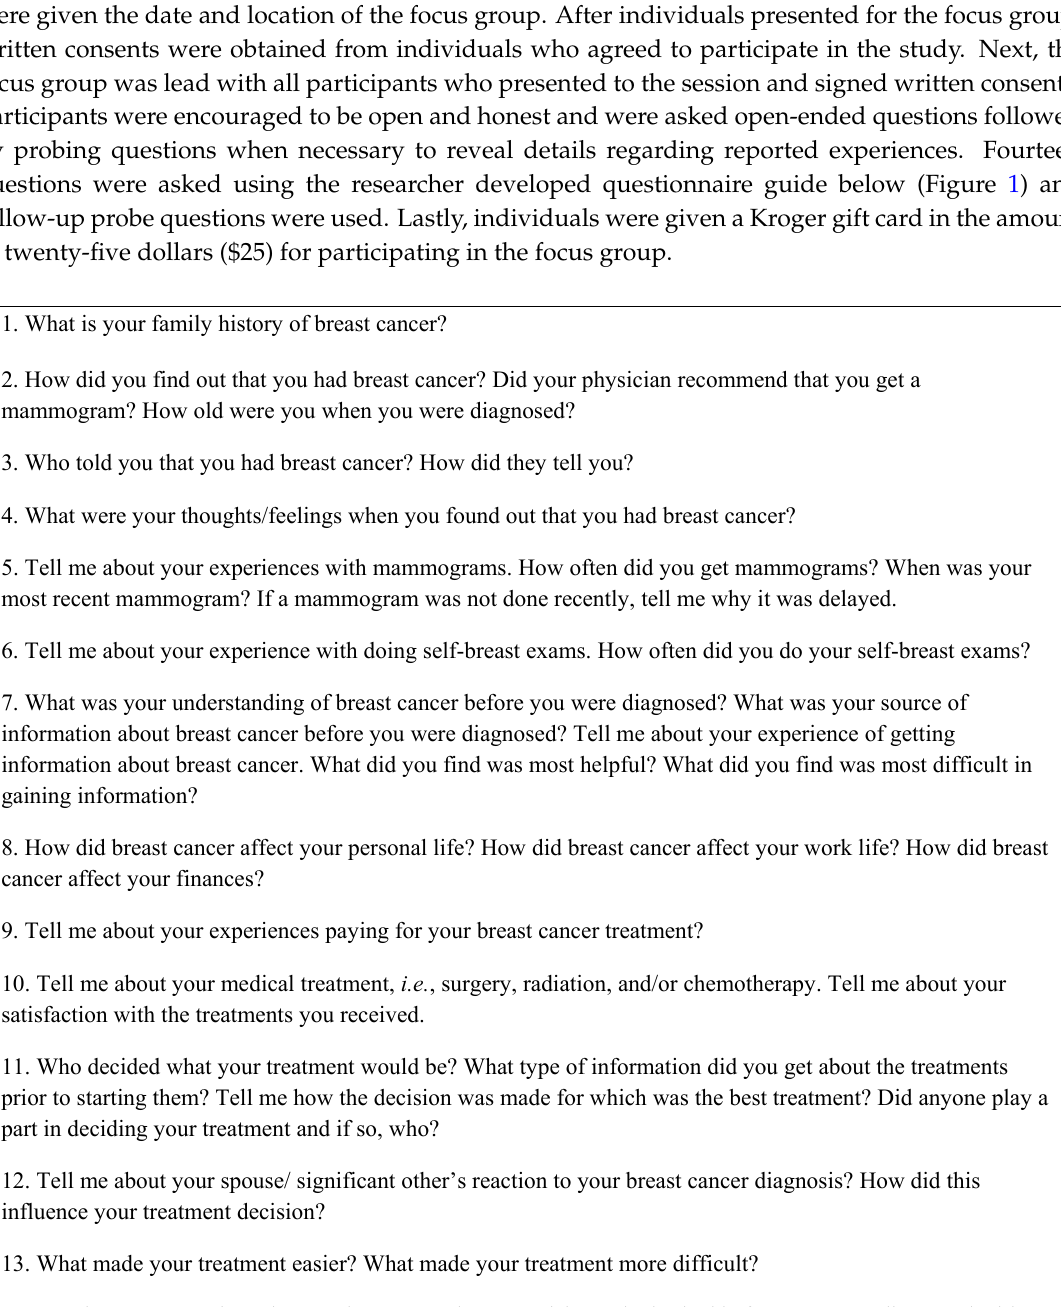
Figure 1. CHEER * study of black women who survived breast cancer: semi-structured interview guide. (* CHEER is the acronym for Consortium on Health Education, Economic Empowerment and Research.)